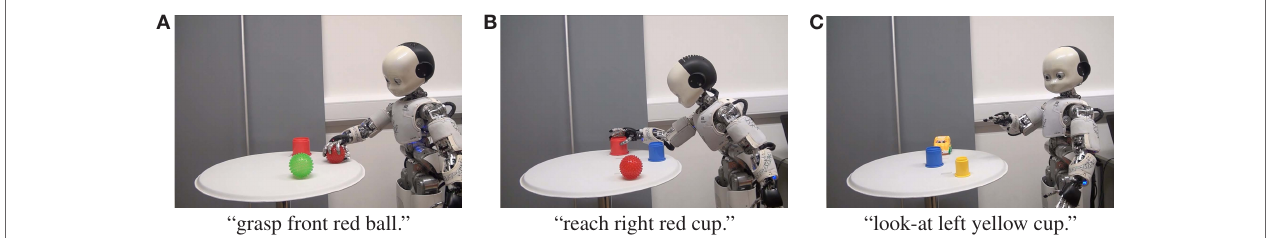
FIGURE 9 | Examples of results of action generation task with real iCub. (A) Grasp front red ball. (B) Reach right red cup. (C) Look-at left yellow cup.